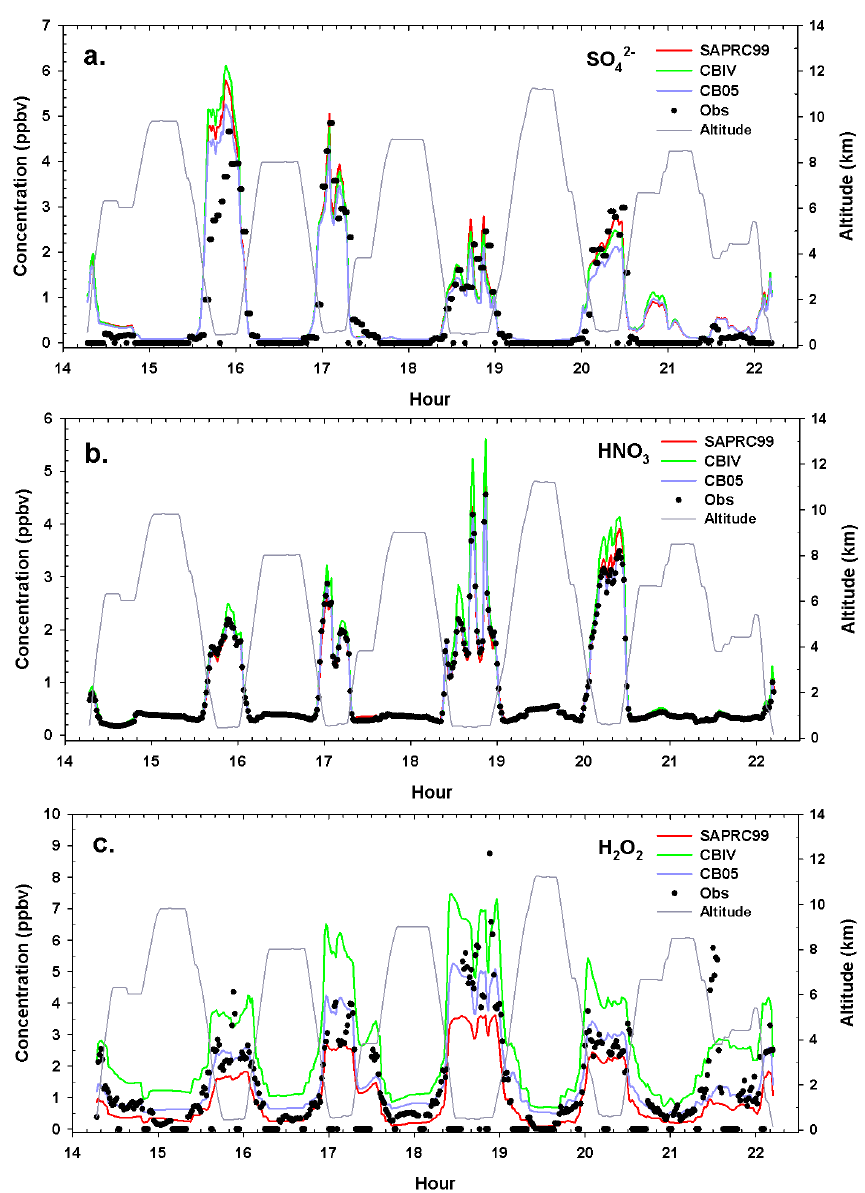
380 Fig. 1. Comparison of modeled vs. observed (a) PM 2 . 5 sulfate; (b) total nitrate; and, (c) hydrogen peroxide concentrations along the path of